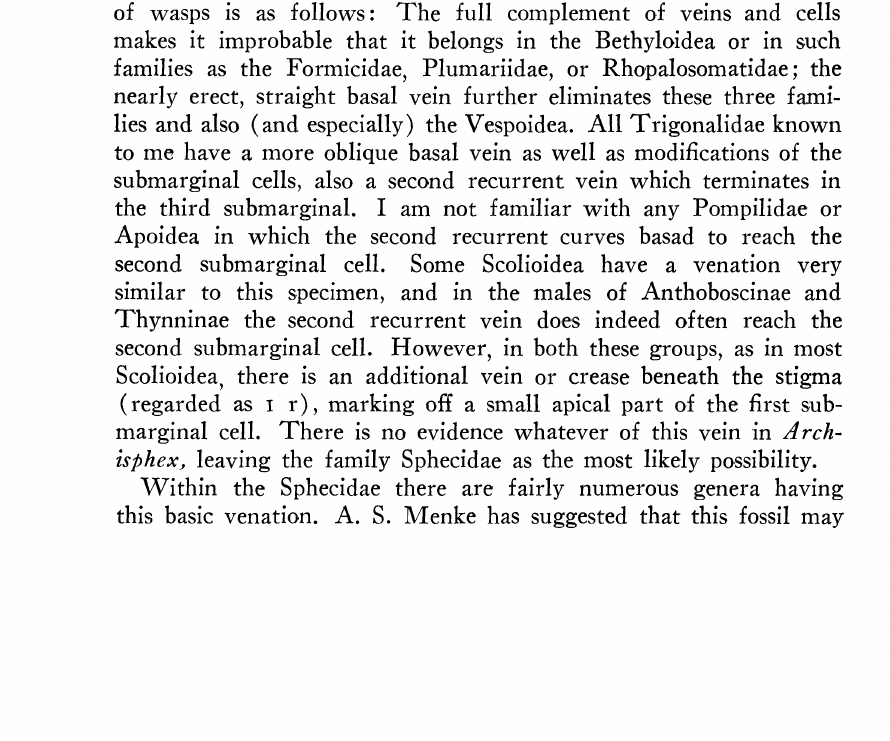
Fig. 1. /lrchiskhex croJsoni n. sp., type specimen (traced from a photo-